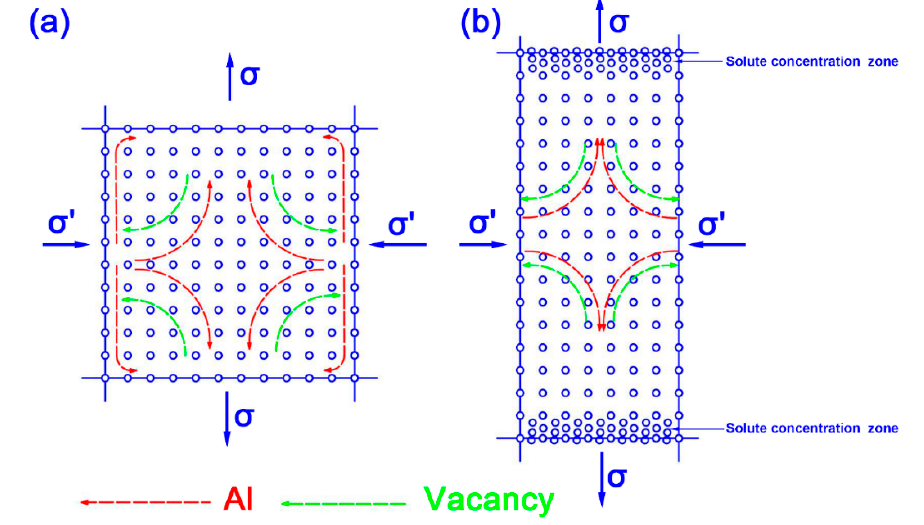
Figure 10. The atom and vacancy diffusion flow schematic diagram in the crept as-extruded AZXSE91000 alloy.